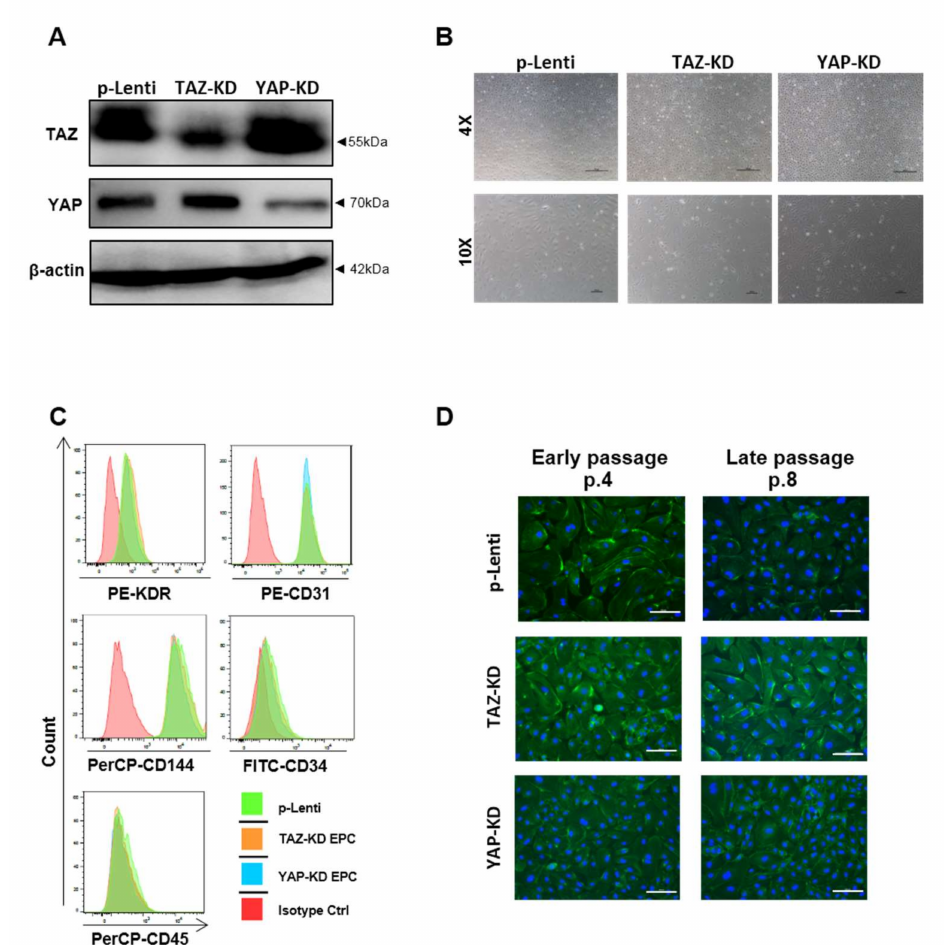
Figure 2. Phenotypic characteristics of YAP and TAZ-knockdown EPCs. Western blotting confirmed the CRISPR/Cas9-mediated knockdown of YAP and TAZ in EPCs ( A ). Phase-contrast microscopic photos of KD cells were illustrated at 4X and 10X magnification ( B ). A representative histogram from FACS analysis of typical surface markers of EPCs, including positivity of CD34, CD31, CD144, KDR, and negativity of CD45, was shown ( C ). Immunofluorescent staining of phalloidin (F-actin; green) for detecting cytoskeletal alignment and nuclear staining by DAPI (blue) in EPCs at early and late passage were presented at 20 × magnification ( D ). Scale bar = 100 µ